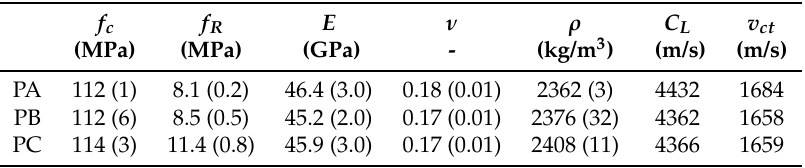
Table 1. Properties of concretes at the age of seven months (values in parentheses are the standard deviations), the longitudinal wave velocity, C L , and the estimated terminal crack velocity, v ct